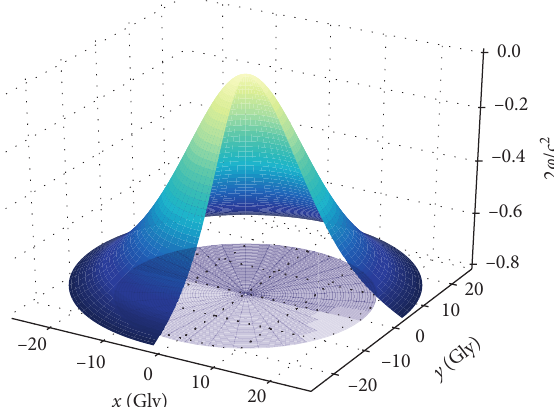
Figure 6: Surface plot of the gravitational potential in the equatorial plane of the antineutrino star. Solving Chandrasekhar’s equation of state for the best-fit parameters gives a radius of cosmological scale, R � 21.1 Gly (shaded area). While baryonic test masses far from the core accelerate down the gravitational potential hill, observers ini- tially at rest and close to the core will remain effectively at rest due to the relatively flat potential gradient here. Thus, the effect of an antineutrino star on galaxies viewed by central observers is com- parable to the effect of a uniformly expanding